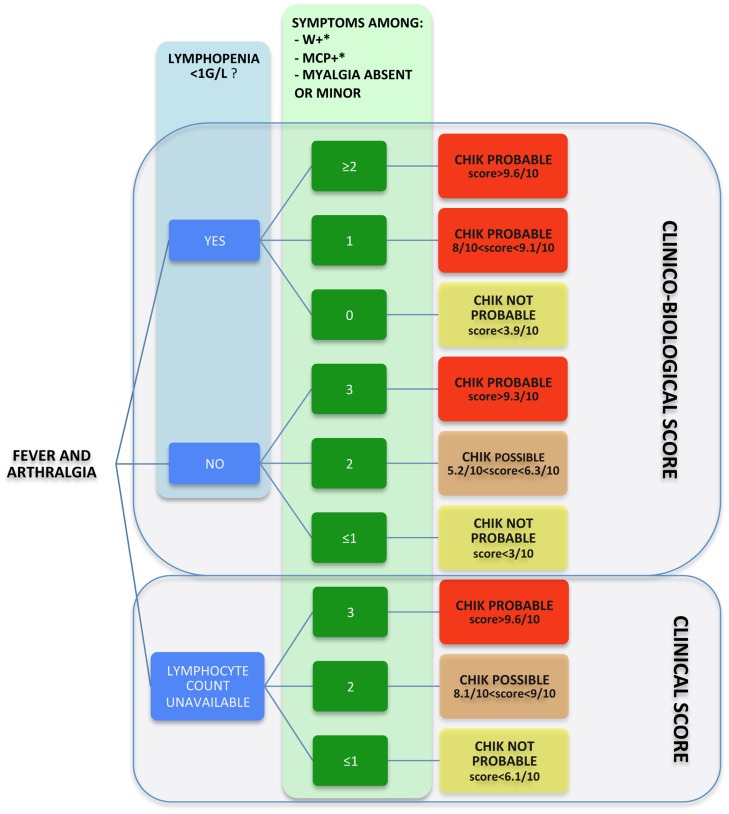
Clinical and clinico-biological score for the diagnosis of CHIK.These scores were based on patients who reported fever and arthralgia for less than 48 hours. * MCP+: arthralgia on at least one metacarpophalangeal joint. * W+: arthralgia on at least one wrist. We propose a clinical score based exclusively on clinical data (W+, MCP+ and Myalgia absent or minor) and a clinico-biological score that further includes lymphopenia (<1G/L). The result of the score represents the predicted probability to have chikungunya (see calculation of scores in the main text).